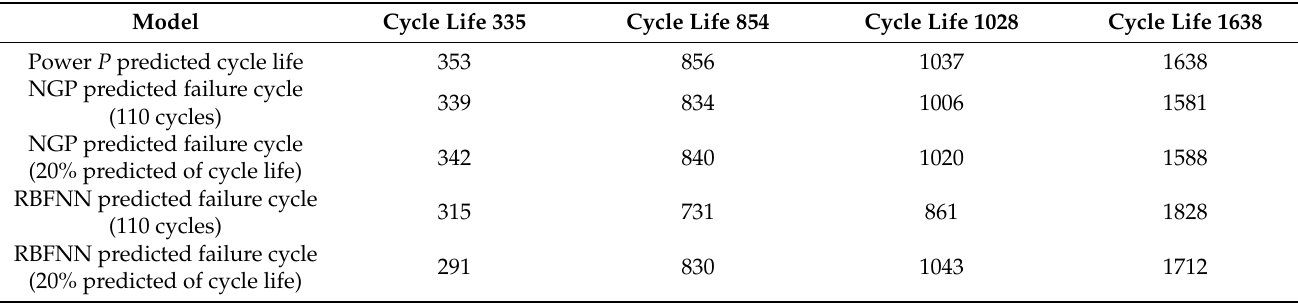
Table 2. Failure cycle life prediction based on NGP and RBFNN models.